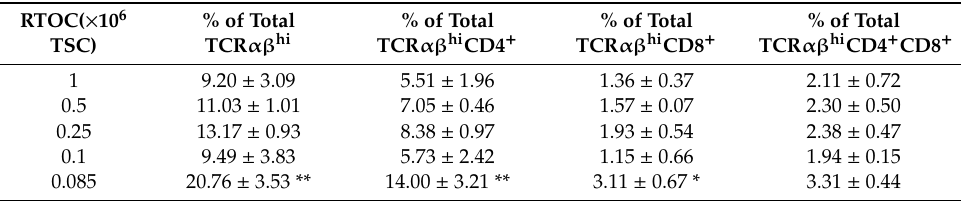
Table 2. Proportions of mature TCR αβ hi